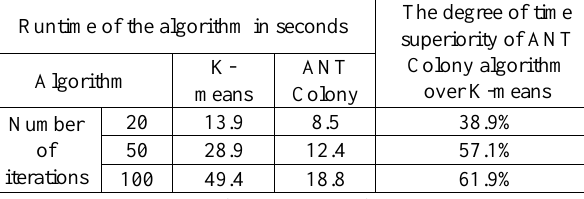
Table 4: Comparison of the run time of the K-means and ANT Colony algorithms in equal number of iterations